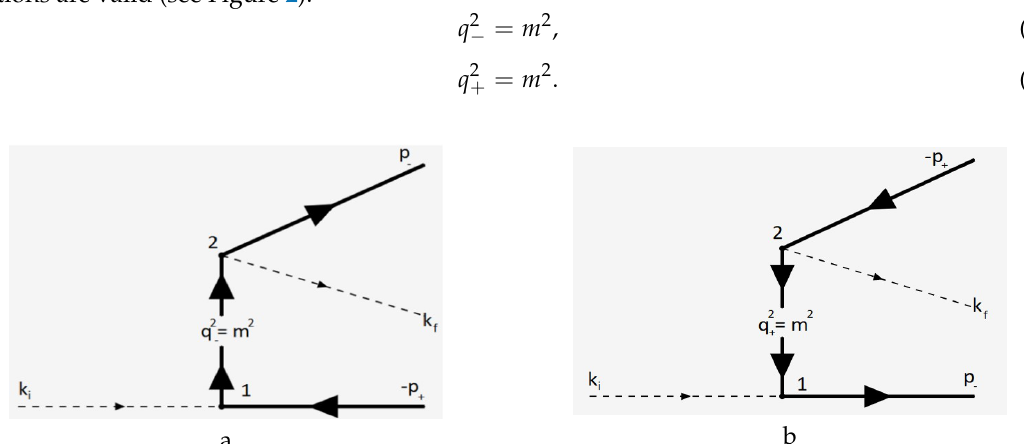
Figure 2. Feynman diagrams of the process of the ( b ) electron–( a ) positron pair resonant production when a gamma quantum collides with an electromagnetic